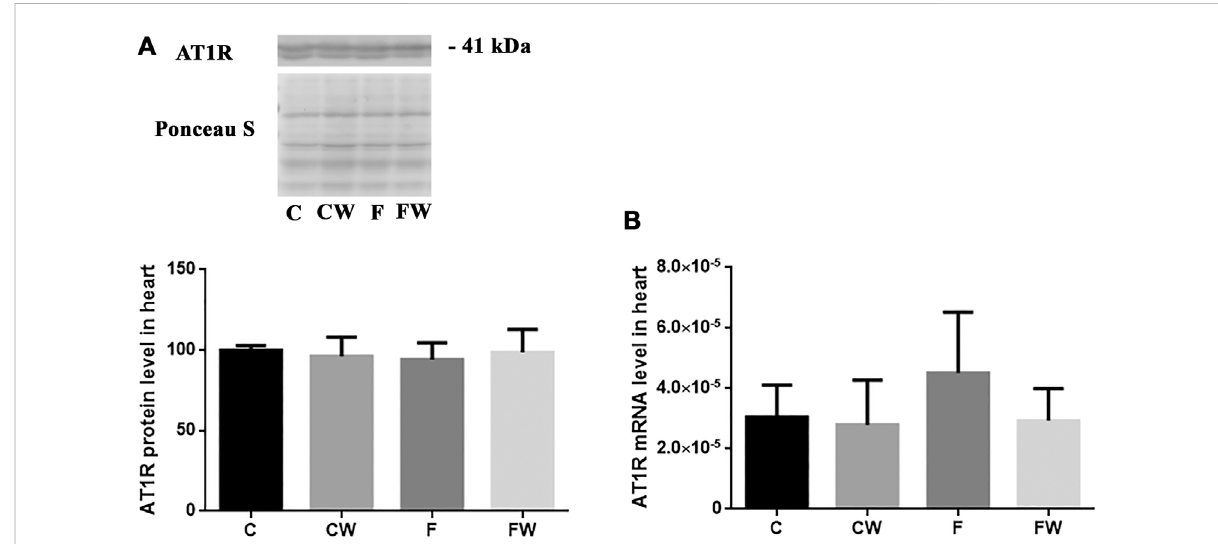
FIGURE 3 Effects of fructose-rich diet and walnut supplementation on (A) protein and (B) mRNA level of AT1R in heart of experimental rats. Values are means with standard deviations represented by vertical bars for 3 samples, each consisting of 3 pooled hearts of the same group. C — animals on